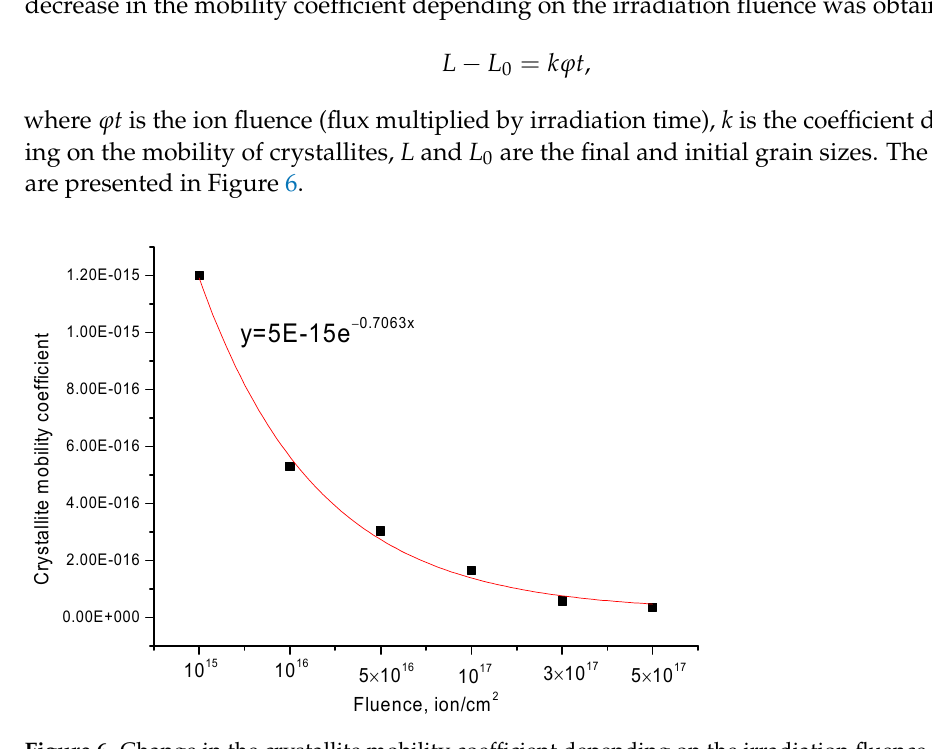
Figure 6. С hange in the crystallite mobility coefficient depending on the irradiation fluence. Figure 6. Change in the crystallite mobility coefficient depending on the irradiation